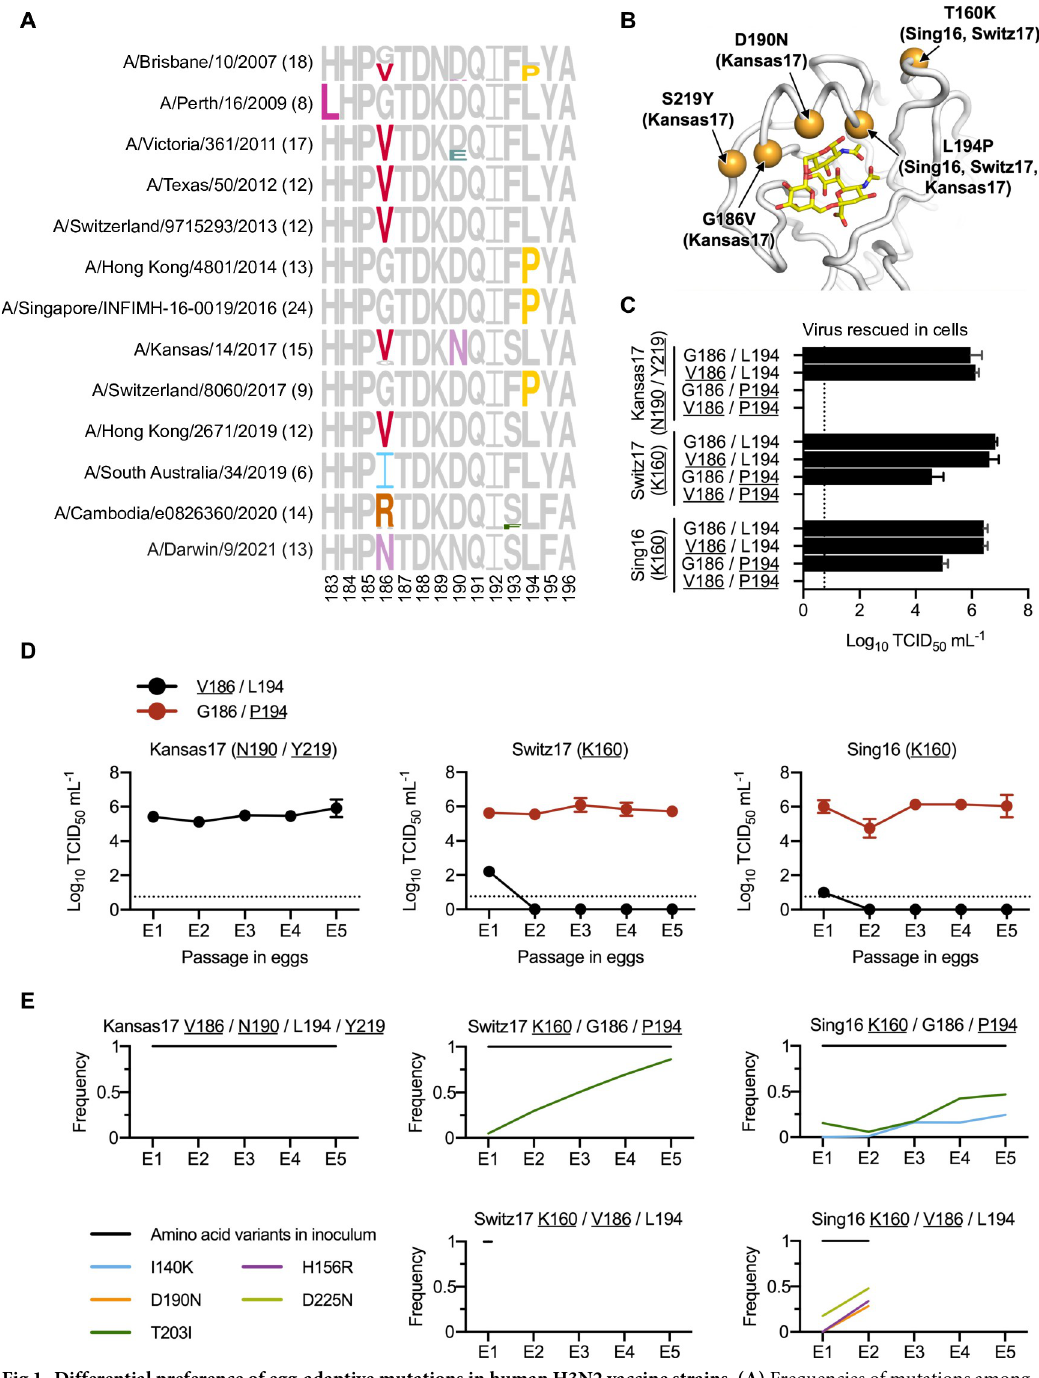
Fig 1. Differential preference of egg-adaptive mutations in human H3N2 vaccine strains. (A) Frequencies of mutations among different egg-passaged seasonal H3N2 vaccine strains are shown as sequence logos. Amino acid variants from residues 183 to 196 are shown (H3 numbering). The number of egg-passaged strains included in this analysis is indicated in the parenthesis. The relative size of each amino acid letter represents its frequency in the sequences. Grey letters represent the amino acid variants that are observed in the corresponding unpassaged parental strains. (B) Key egg-adaptive mutations in this study are shown in orange (PDB 6BKT) [17]. Sialylated glycan receptor is in yellow sticks representation. Strains in parentheses are associated with the corresponding egg-adaptive mutations. Only three strains of interest (Sing16, Switz17, and Kansas17) are included here. (C) Replication fitness of different mutants of human H3N2 vaccine strains was examined in a virus rescue experiment in mammalian cells (293T/hMDCK). Viral titers were measured by TCID 50 . (D) The viral titer of each human H3N2 vaccine strain with either